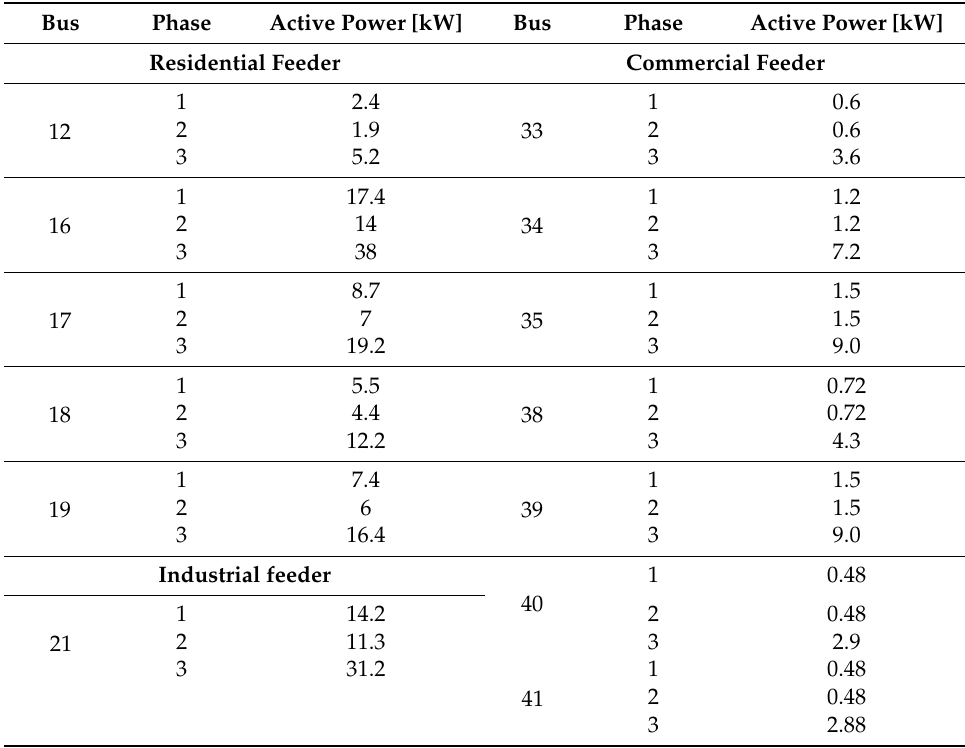
Figure 3. Input data: per unit power profiles of a residential ( a ), an industrial ( b ) and a commercial ( c ) load [45]. Table 6. Peak Active Power and location of